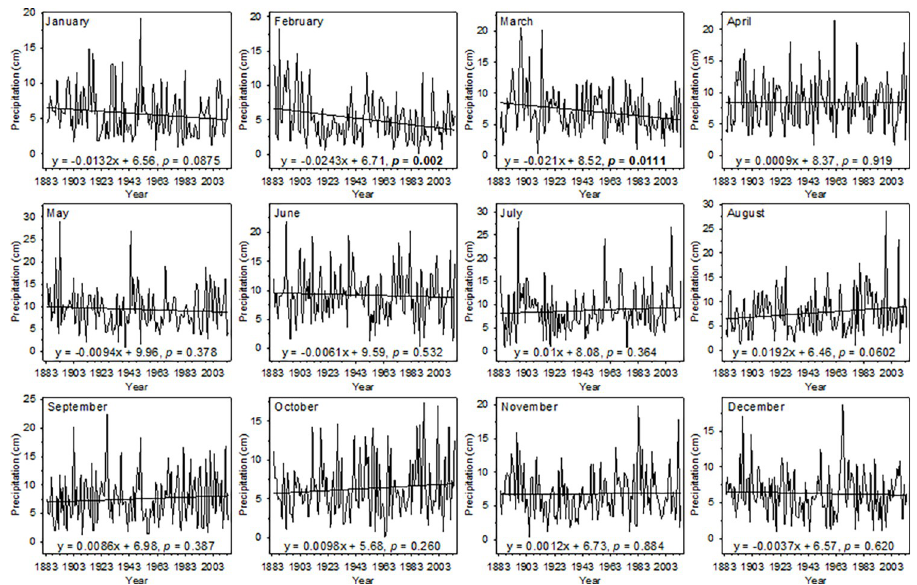
Fig 2. Trends in total precipitation for each month in Wauseon, OH from 1883–2013. Simple linear regressions were used to calculate the rate of change in precipitation amounts in each month (cm/year) over the 131-year period. Significant p -values are given in